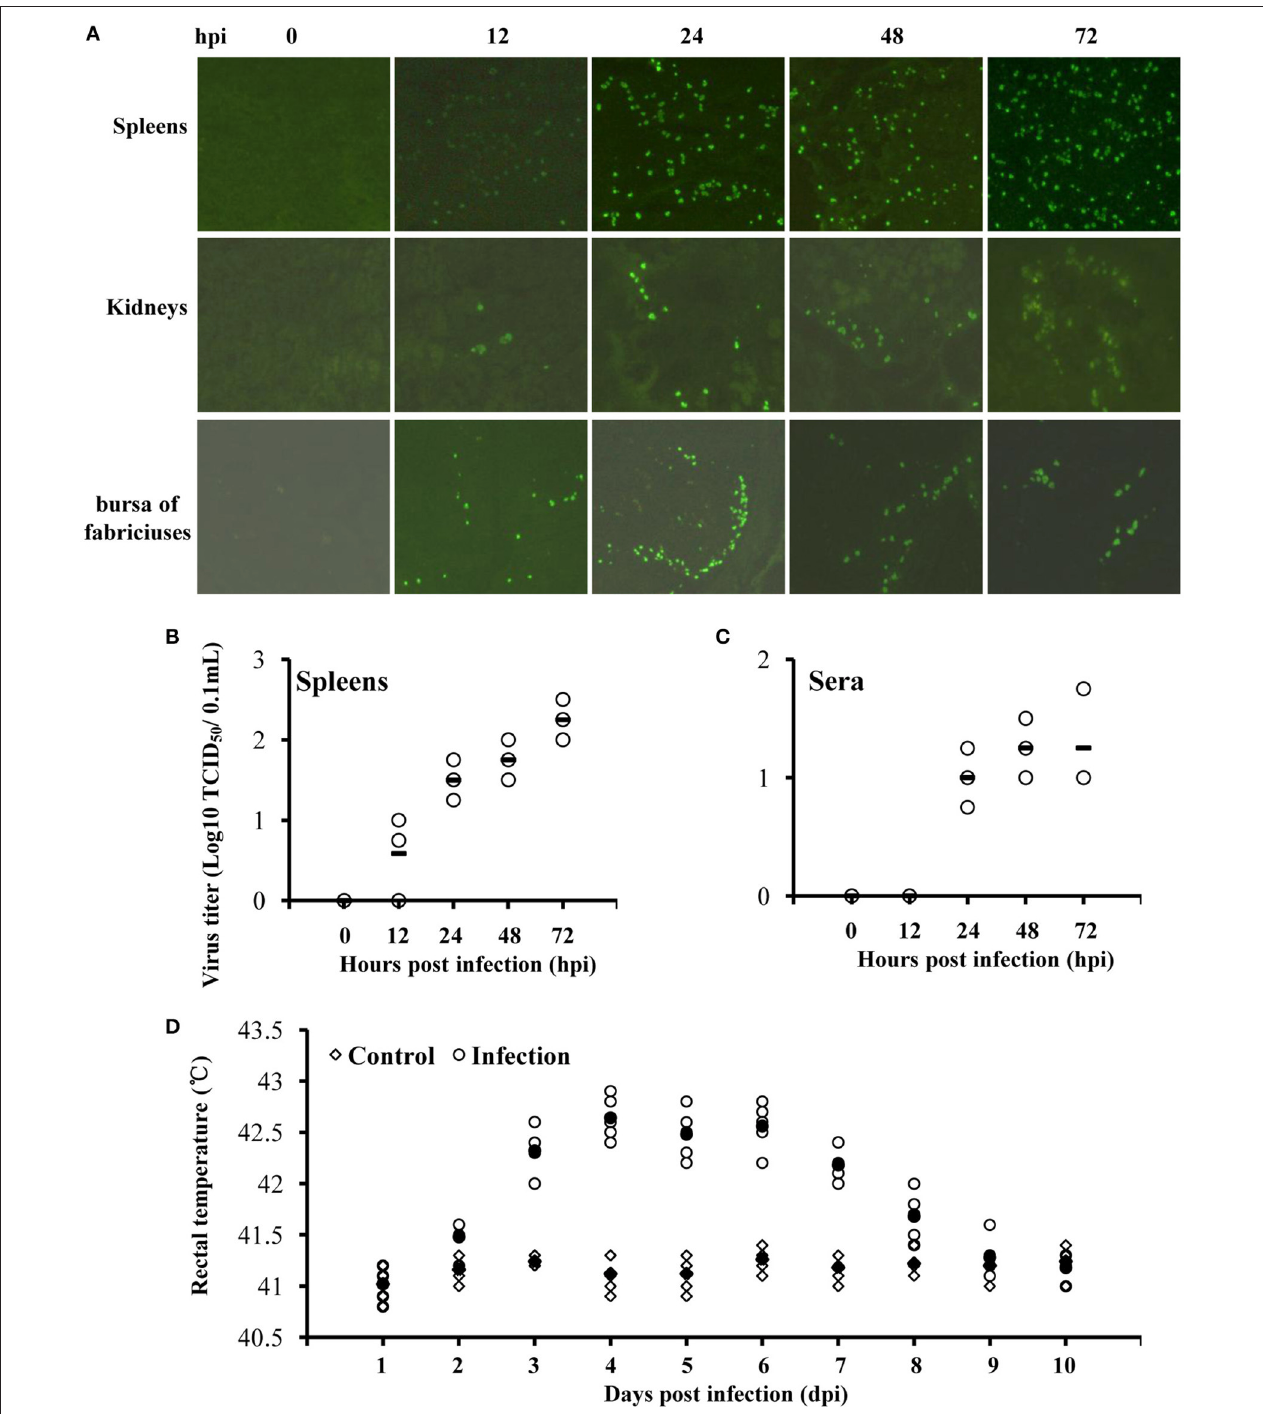
FIGURE 1 | ATMUV exhibits mild pathogenicity in mule ducklings following intramuscular injection. Twenty five 7-day-old healthy mule ducklings were challenged by intramuscular injection with 4.0 × 10 5 ELD 50 of ATMUV in a volume of 0.4mL per duckling. Ten same old ducklings were inoculated with 0.4 mL sterile PBS per duckling as a control. Three randomly selected ducklings were sacrificed at 0, 12, 24, 48, and 72 hpi, respectively. (A) Their organ tissues were harvested for detection viral infection by IFA. (C) The sera and (B) spleen homogenates of the ducklings at 0–72 hpi were prepared for detection the viral titer by TCID 50 assay in DEF cells. (D) Five randomly selected ducklings in infected group and control group, respectively, were monitored rectal temperatures daily.